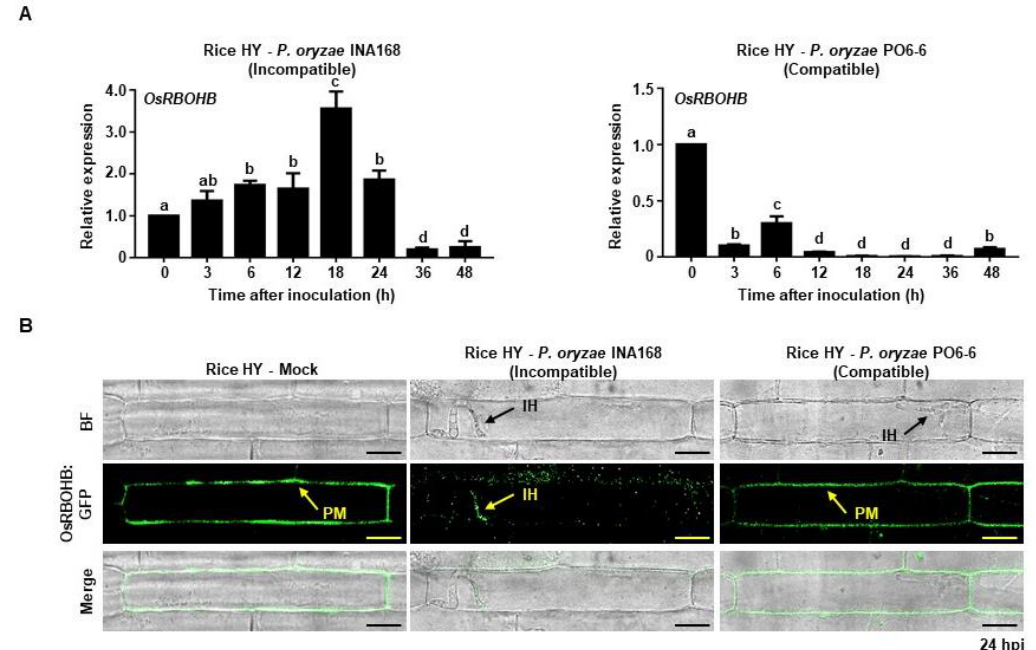
Figure 1. OsRBOHB- focally accumulated around invasive hyphae during incompatible rice – P. oryzae interaction. ( A ) Transcriptional analysis of OsRBOHB in rice leaf sheaths after inoculation with P. oryzae incompatible strain INA168 and compatible strain PO6-6. The OsRBOHB expression level was detected at different time points using quantitative real-time PCR (qRT-PCR) after normalizing with respect to the housekeeping gene Ubiquitin . The results were presented as means ± SD of relative expression levels from three independent experiments. Letters above the bars indicate significant differences in relative expression at different time points (one-way ANOVA, p < 0.05, n = 3). ( B ) Localization of GFP-tagged OsRBOHB in epidermal cells of rice cv. HY after inoculation with P. oryzae incompatible INA168 and compatible PO6-6. OsRBOHB:GFP fluorescence is indicated by arrows in rice cells. Scale bars = 10 µm. All images were captured using confocal laser microscopy with bright field or green fluorescence filter (488 nm excitation/505 – 550 nm emission). BF, bright field; IH, invasive hyphae; PM, plasma membrane.